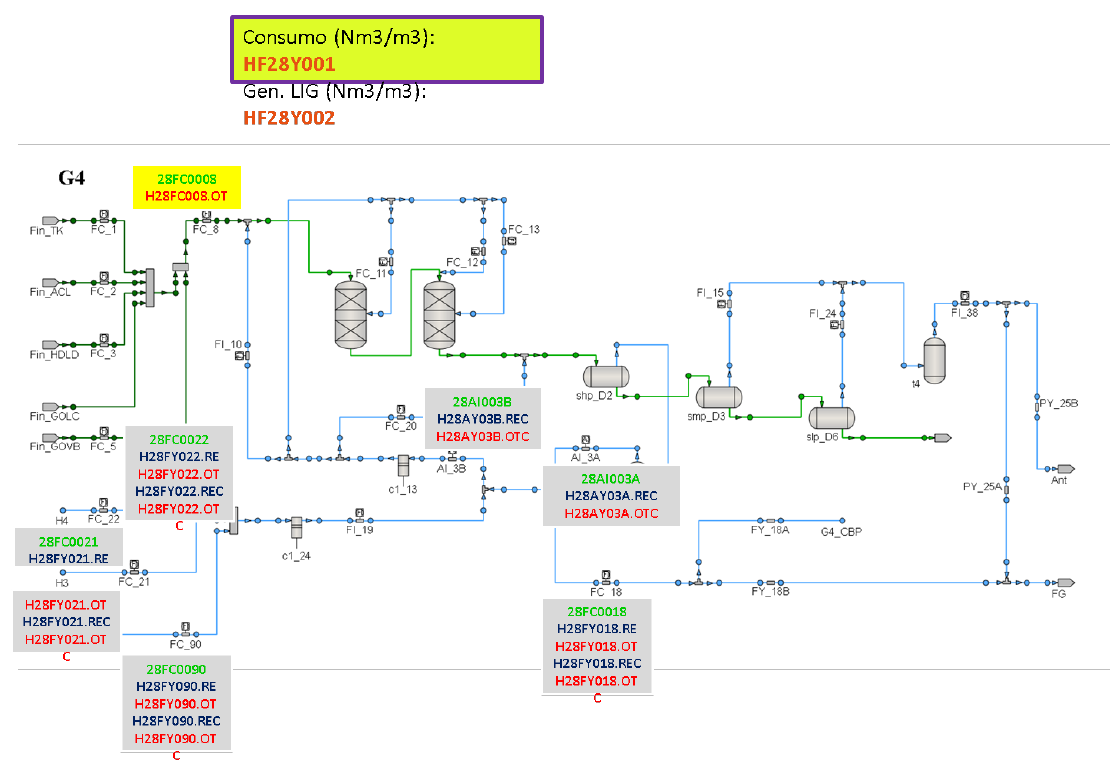
Figure 10. Schematic of a consumer plant showing the tags of measured, reconciled and optimized key variables and REIs. They can be further displayed graphically.